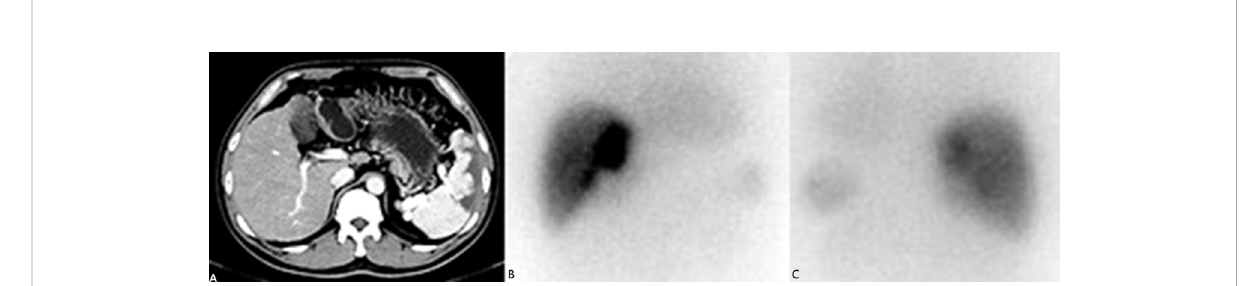
FIGURE 1 (A) The liver computed tomography suggested the postoperative stump recurrence of the right lobe (5.8 × 3.6 cm 2 ). High density shadow of spleen could be seen. This patient had splenic artery embolism before due to hypersplenism; (B) The anterior image of the hepatic area in 131-I whole-body scanning revealed increased 131-I uptake in recurrent tumors; (C) The posterior image of the hepatic area in 131-I whole-body scanning revealed increased 131-I uptake in recurrent